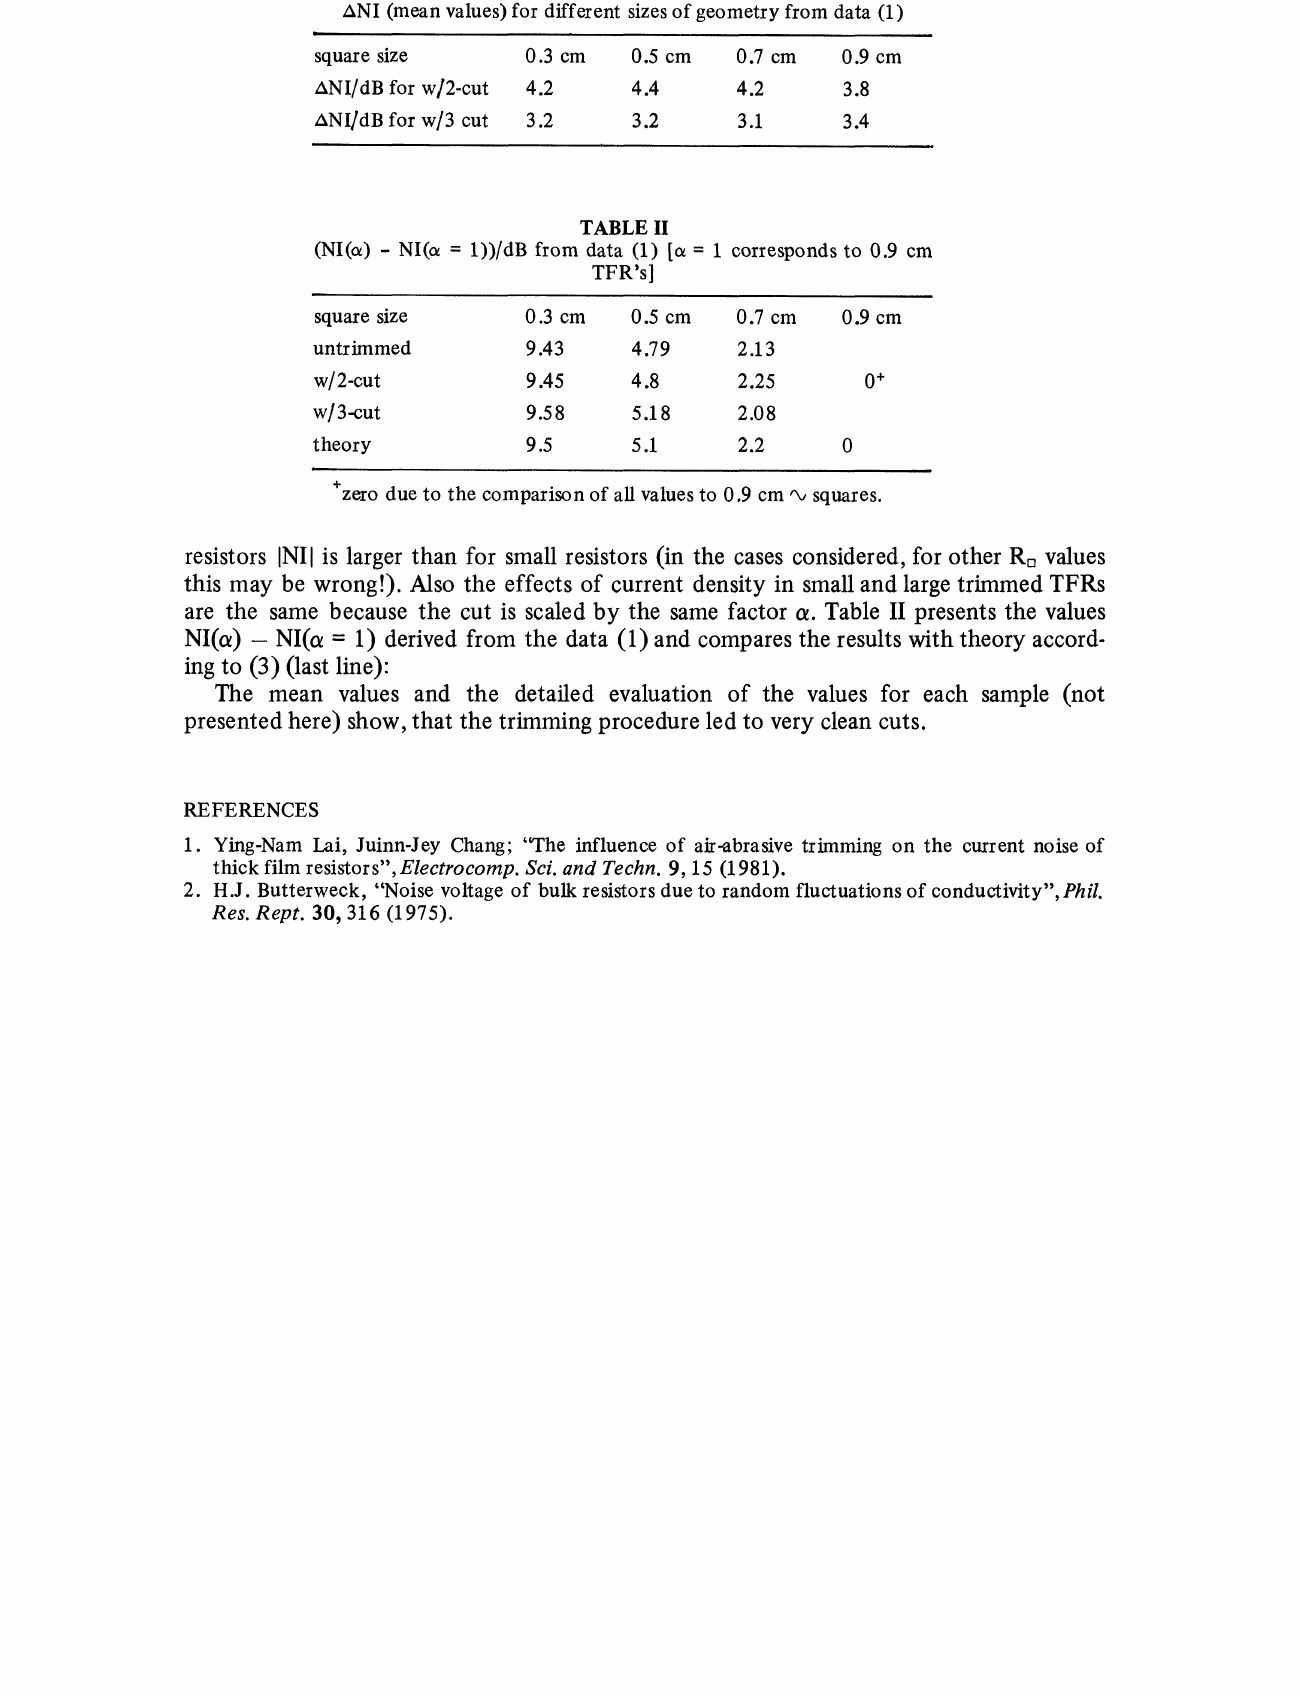
TABLE zNI (mean values) for different sizes of geometry from data (1)